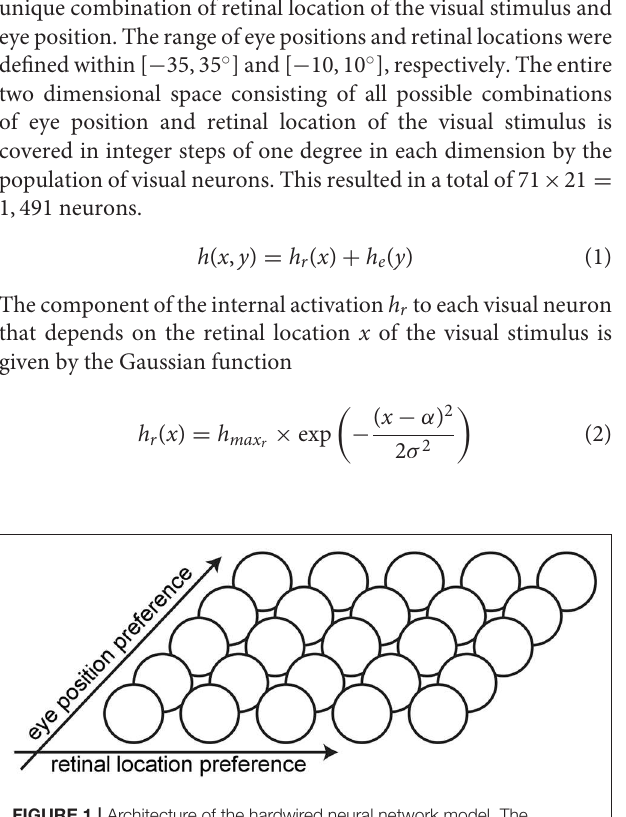
Frontiers in Neural Circuits |